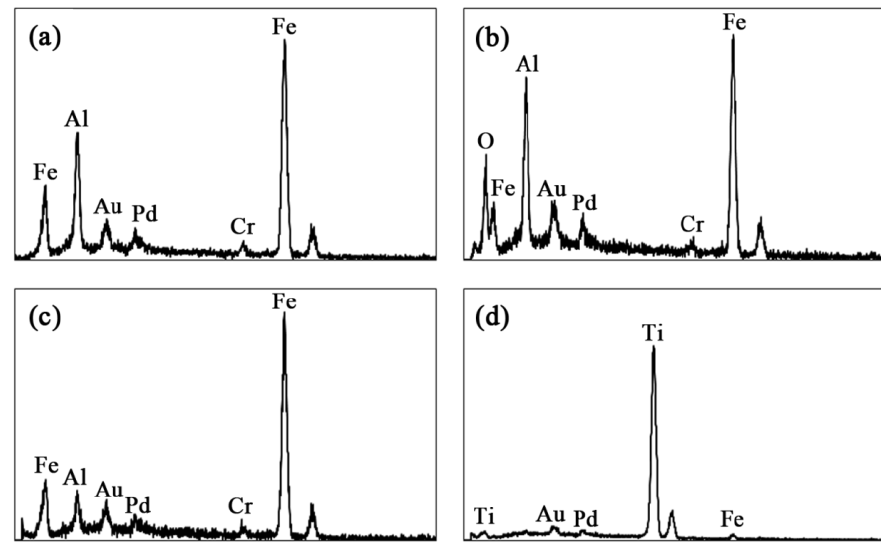
Figure 3. EDS spectra of the ( a ) main grey phase in Fe 3 Al coating; ( b ) dark grey oxide inclusions; ( c ) light grey areas and ( d ) TiB 2 particles.